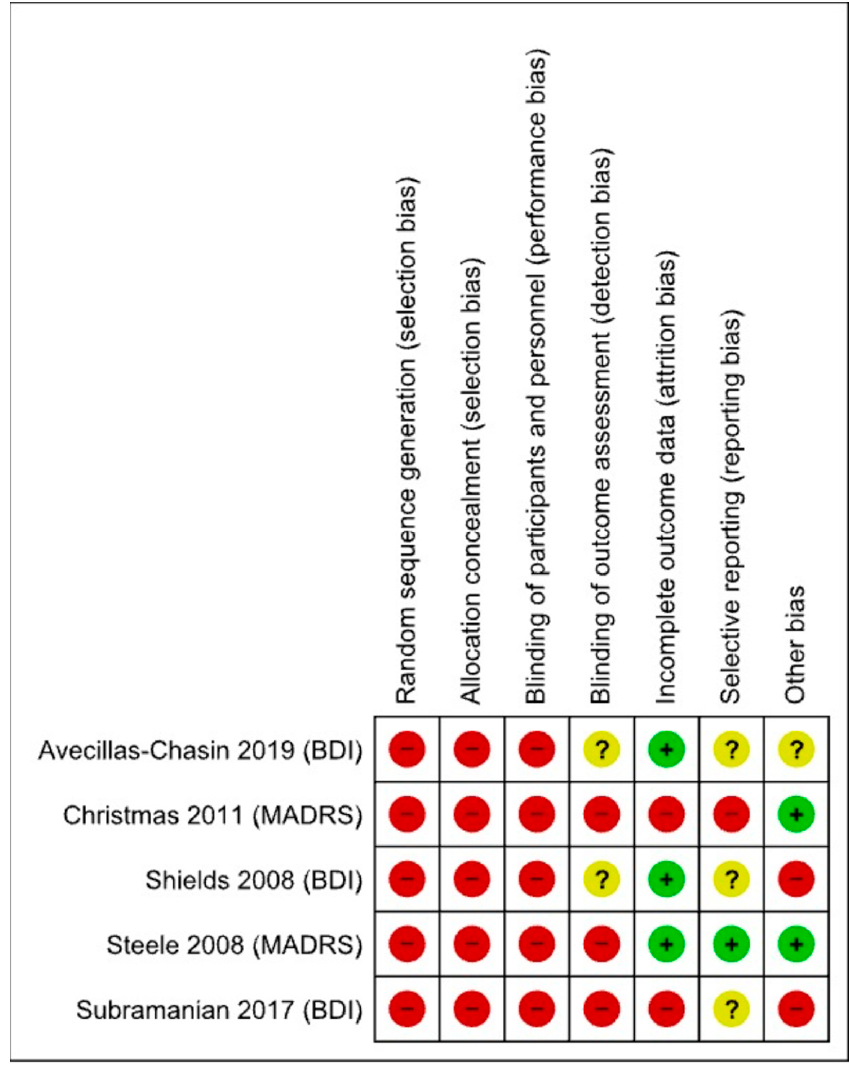
Figure 3. Risk of bias summary for included studies, using the Cochrane risk of bias tool. Red = High risk; Green = Low risk; Yellow = Unclear. [10,18–21].